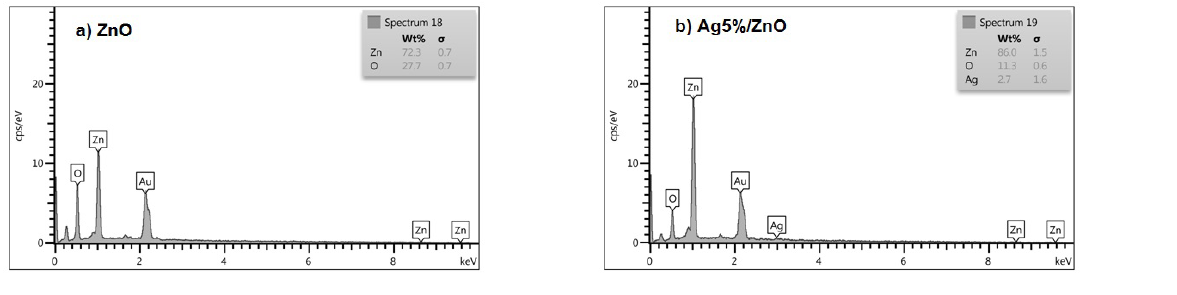
Figure 3. EDX spectra of nanoparticles synthesized using sol-gel process (a) zinc oxide (ZnO) and (b) silver (Ag)